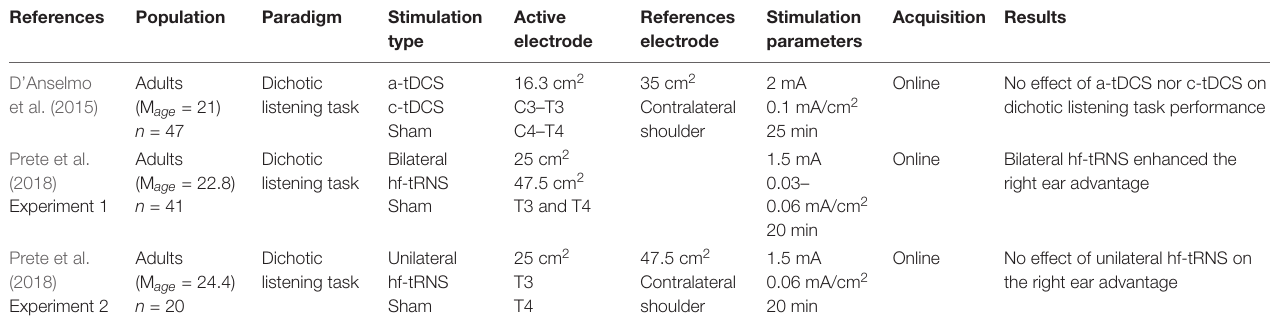
TABLE 4 | Binaural